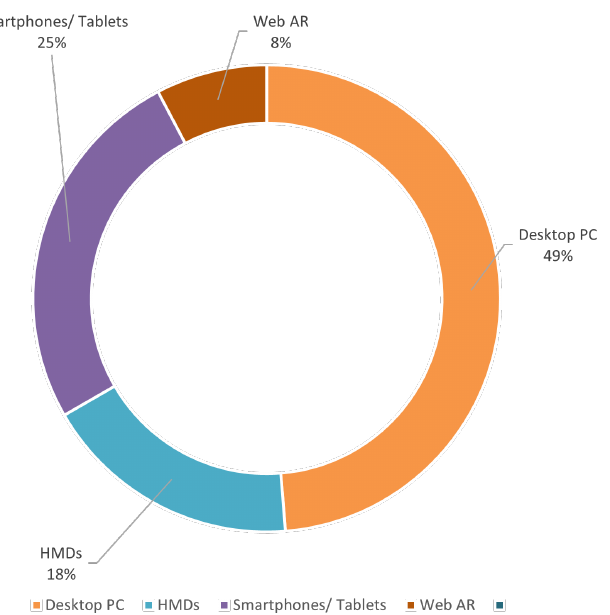
Figure 6. Distribution of display devices used in AR educational